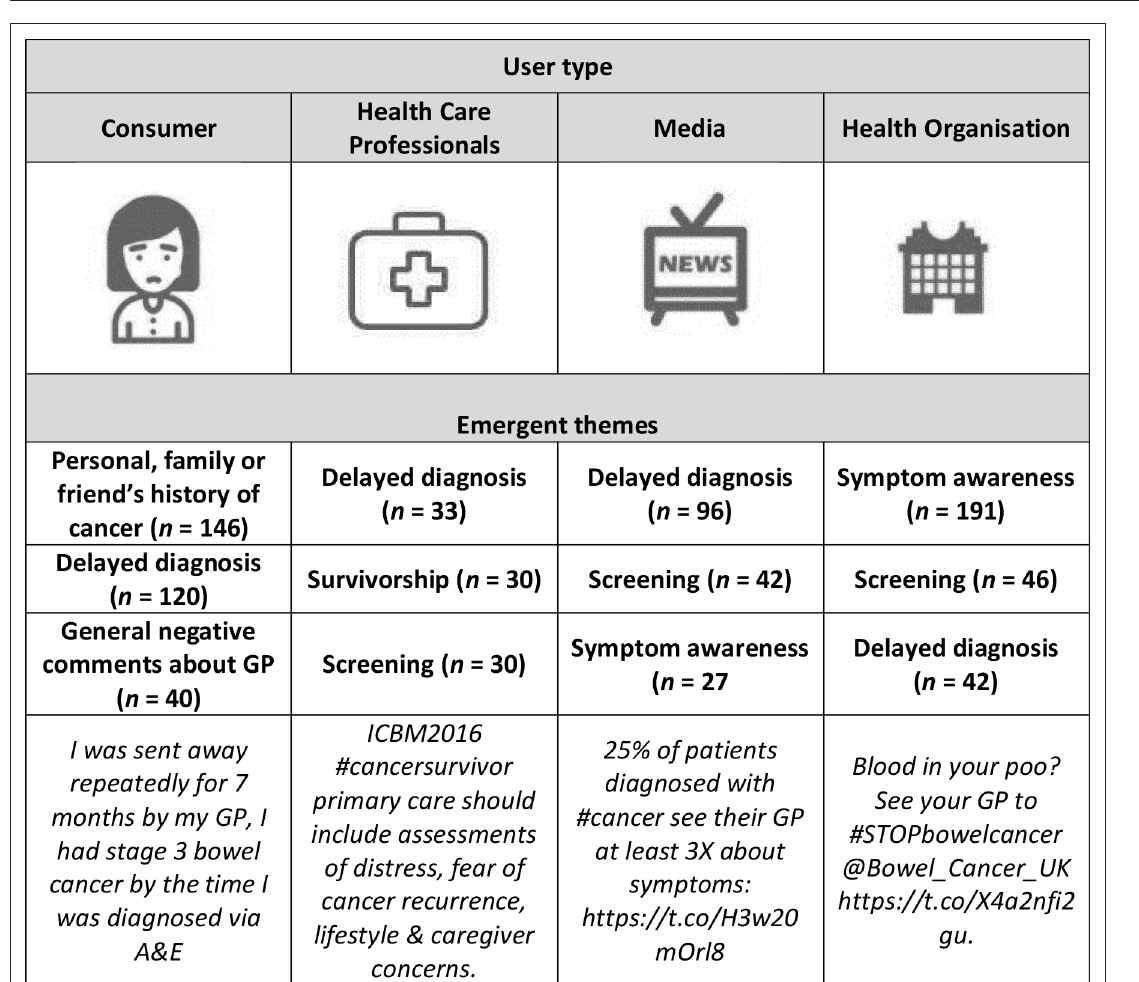
Figure 2 Emergent themes in cancer in primary care tweets by user type: consumers, media, healthcare professionals, and health